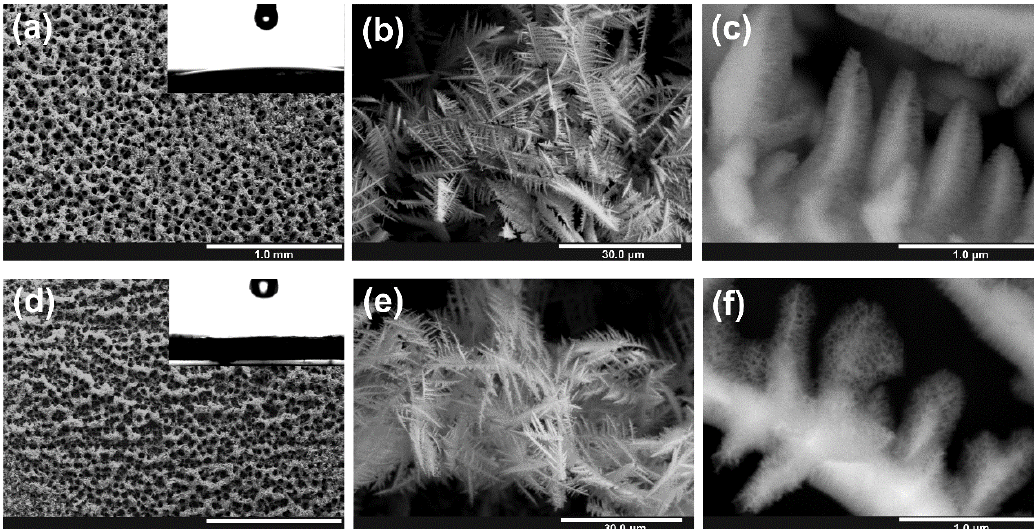
Figure 3. FE-SEM images of anodic Sn / SnO x foams obtained by anodic oxidation of metallic foams in 1 M NaOH electrolyte at the potential of 4 V during 600 s ( a – c ) and 1200 s ( d – f ).